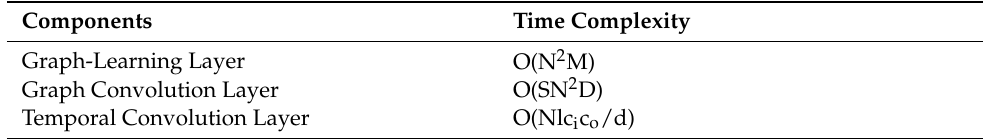
Table 7. Results of the time complexity analysis. Components Graph-Learning